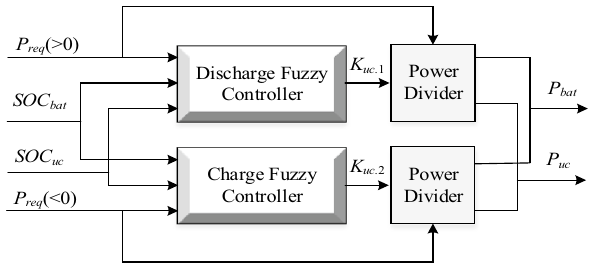
Fig. 4 Structure of fuzzy controller for vehicle hybrid power